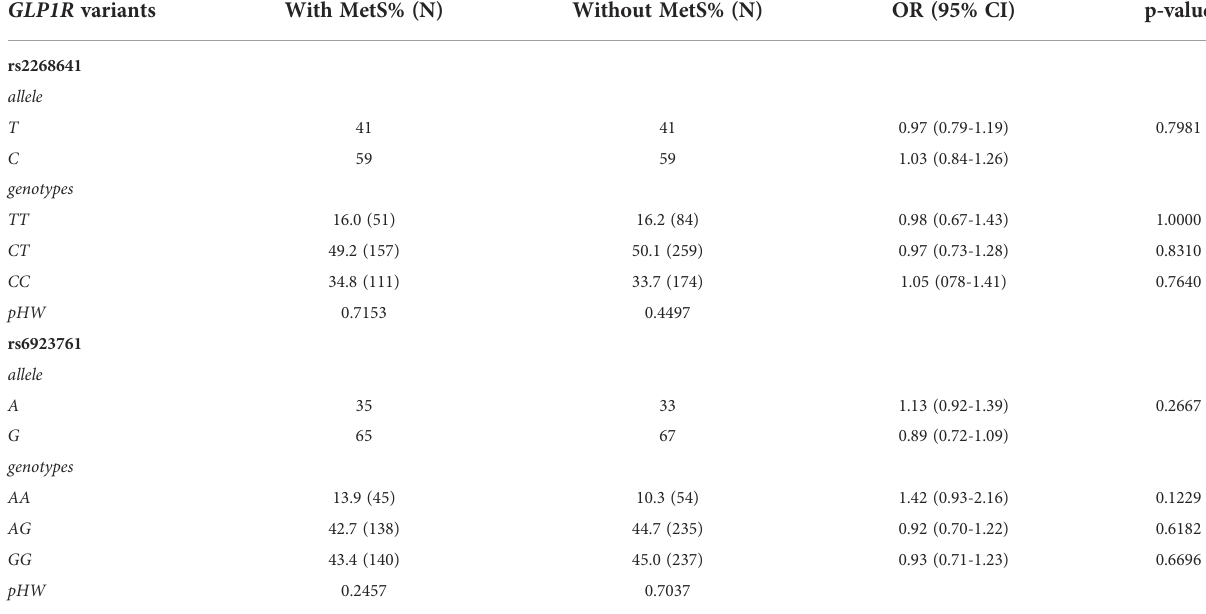
TABLE 3 The frequencies of GLP1R variants in the group with and without metabolic